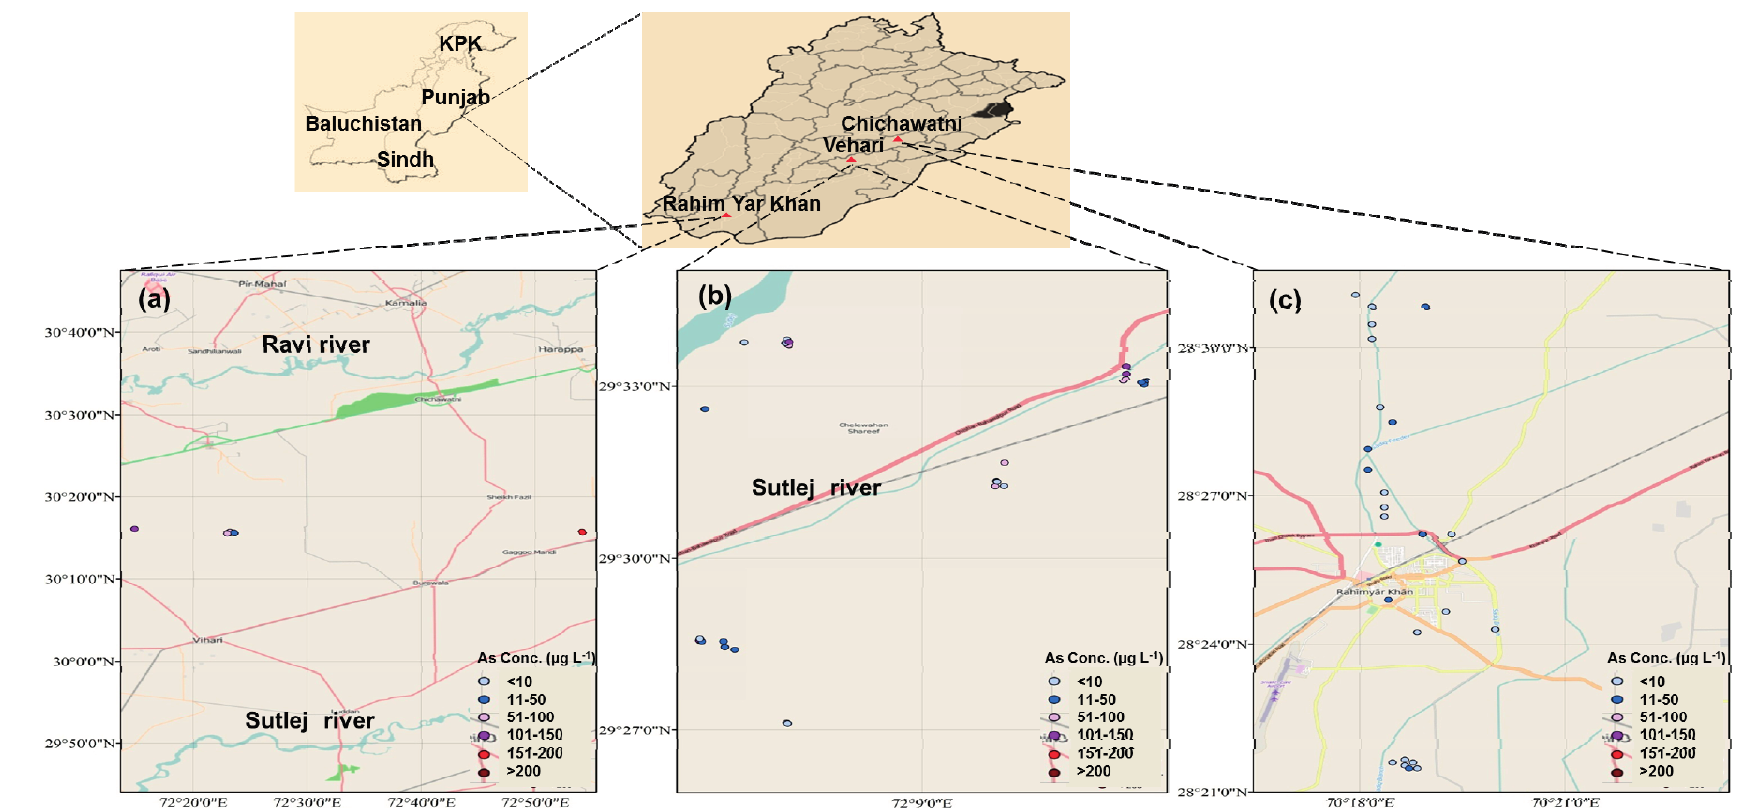
Figure 1. Map of the study area showing locations of groundwater sampling for As (µg·L − 1 ) in Punjab, Pakistan; ( a ) Chichawatni; ( b ) Vehari; ( c ) Rahim Yar